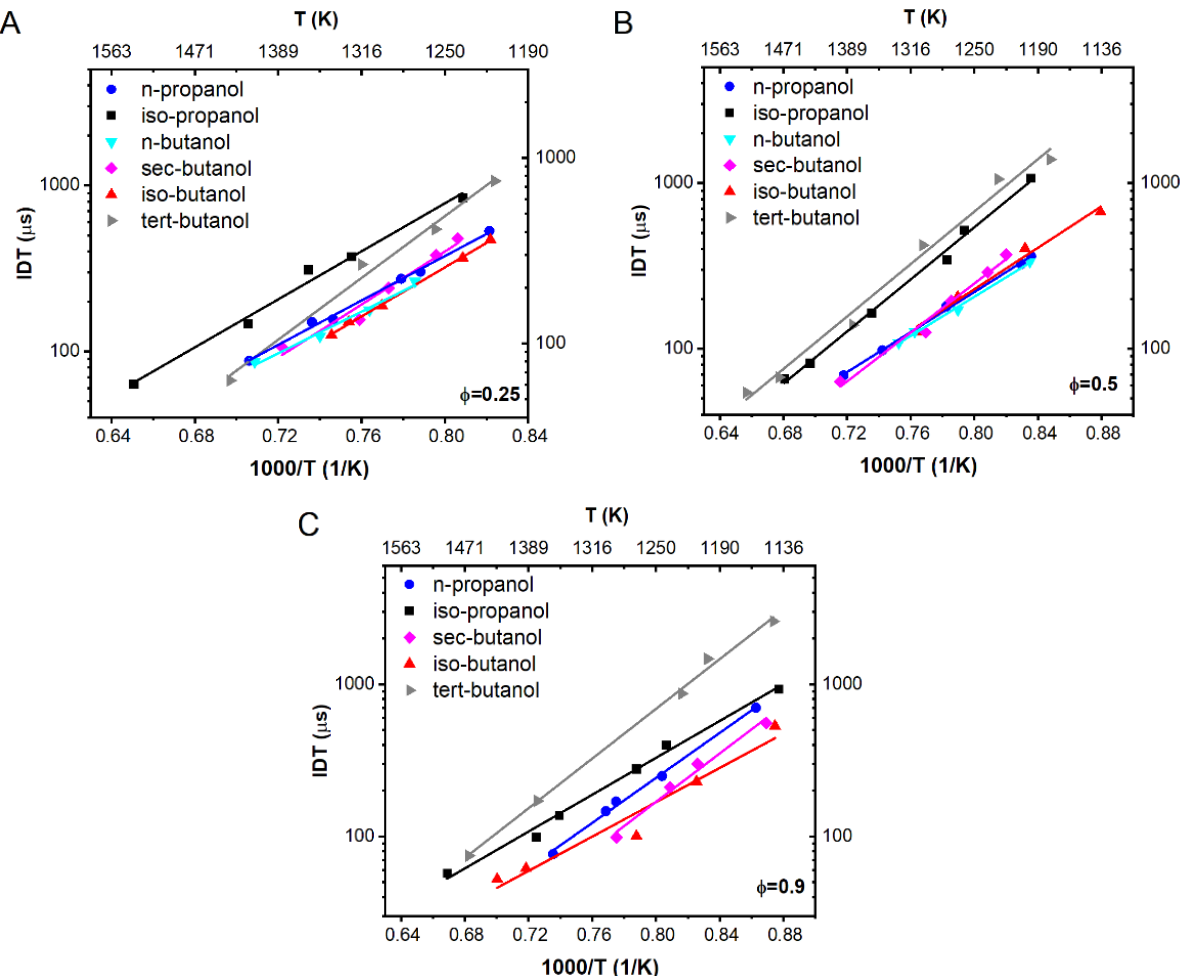
Figure 2. Ignition delay times (IDTs) of propanol and butanol isomers measured in this work in HPST at 10 bar, and ( A ) ϕ = 0.25, ( B ) 0.5 and ( C ) 0.9.